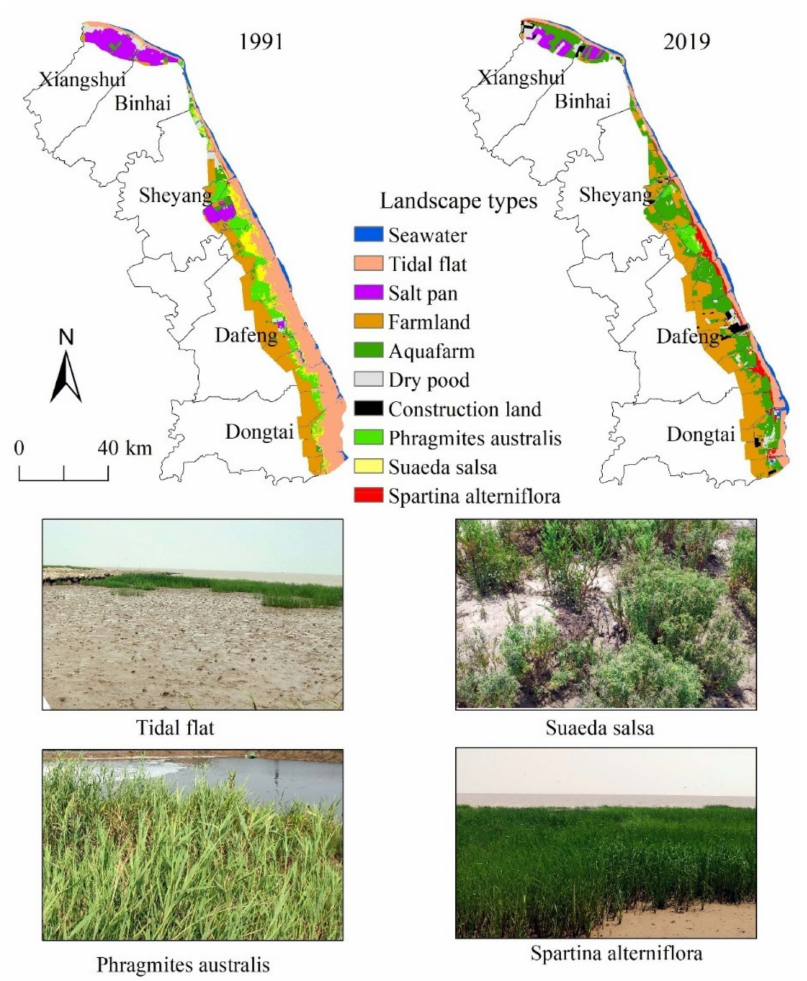
Figure 4. Landscape pattern characteristics of Yancheng coastal